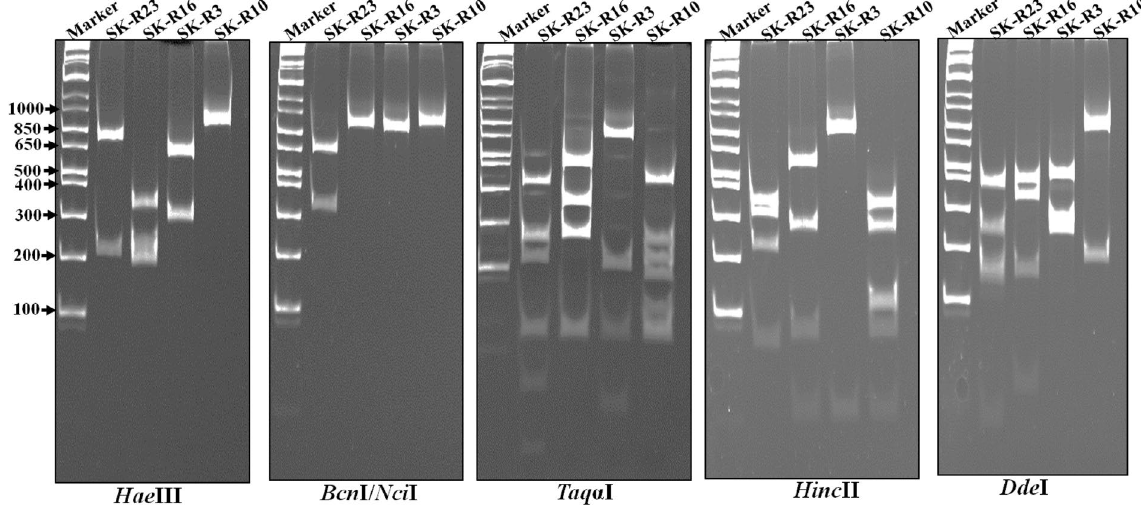
Figure 4. Polyacrylamide gel electrophoresis of the Sigma C RT-PCR products (~960 bp) following digestion with the indicated restriction enzymes. The DNA molecular weight markers are indicated on the left.